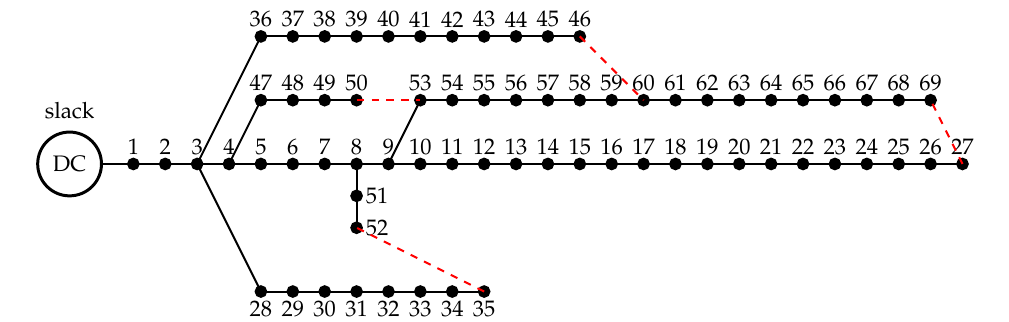
Figure 5. Line diagram of the 69-bus test system.